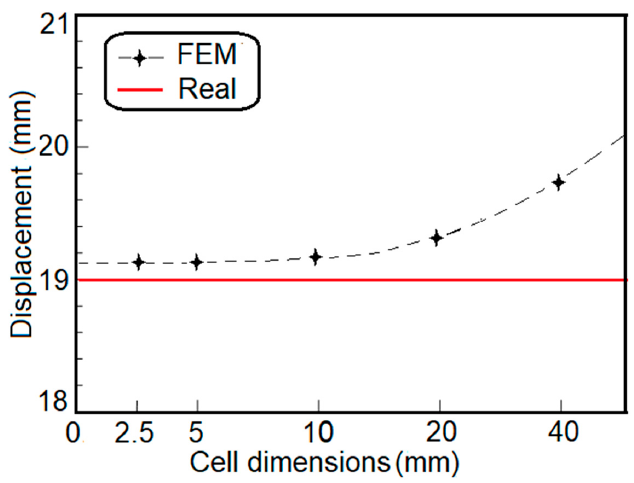
Figure 5. Cell dimension vs. displacements calculated at point B. Comparison with the experimental displacements (RINA test report n. 2016CS011021/14 2017).